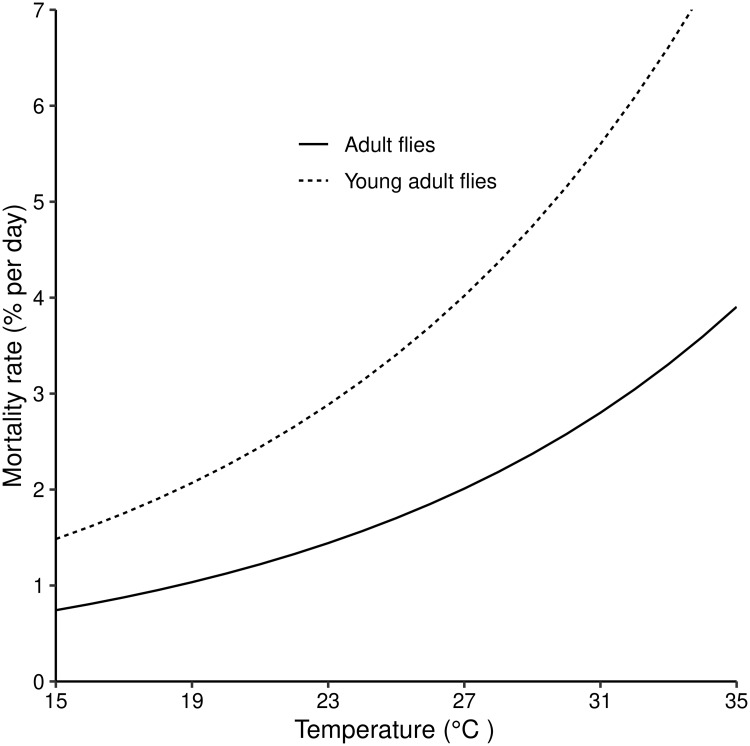
Daily mortality rates for young adult and mature adult female G. m. morsitans for temperatures ranging from 15°C–35°C.Eqs (10) and (11) plotted for different temperatures.